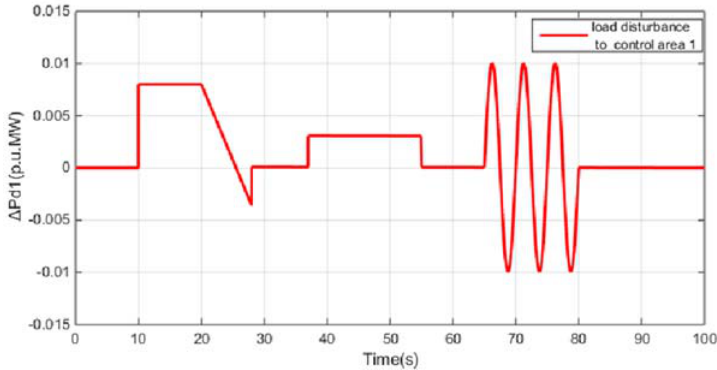
Figure 7. The external load disturbance added to Control Area 1.